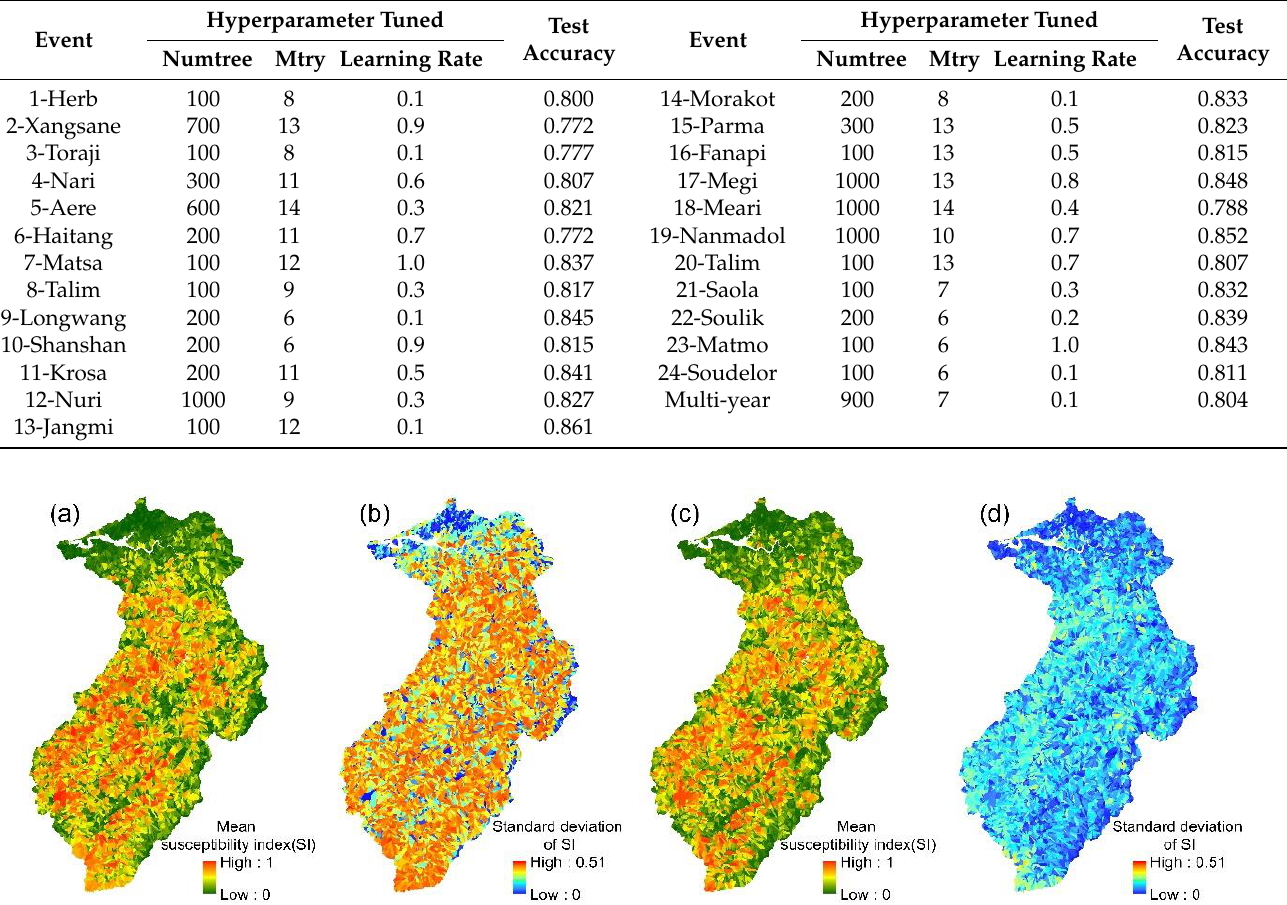
Figure 8. GBDT models: ( a , b ) the mean susceptibility index and standard deviation of 24 event-based models; ( c , d ) the mean susceptibility index and standard deviation of the multi-year model.